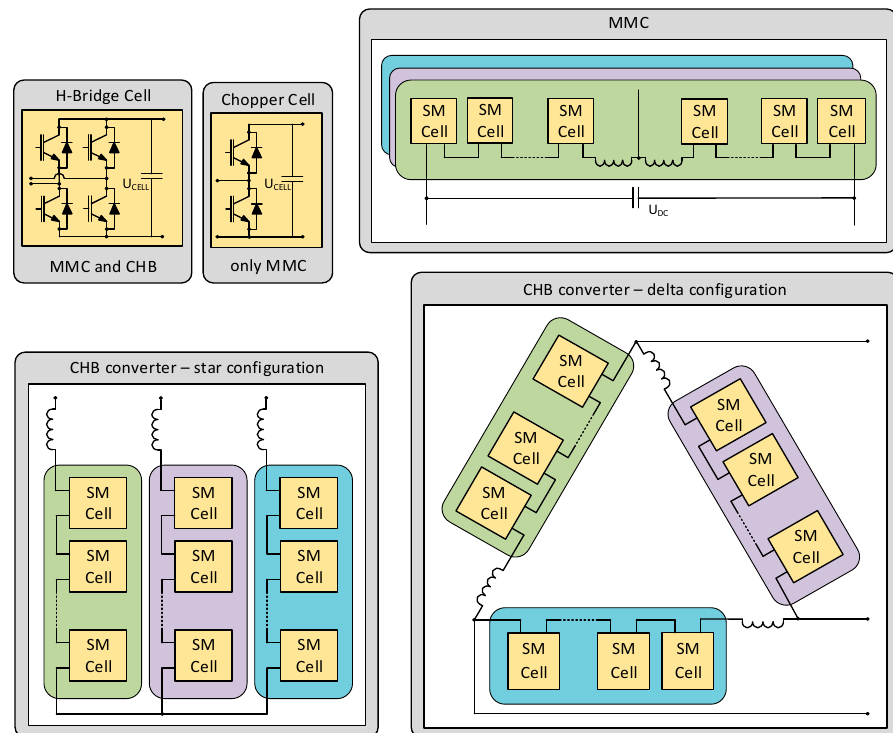
Figure 2. Modular multilevel converter and cascaded H-bridge converter topologies. The main topological difference is that MMC does have a common MV-DC link, while CHB does not. The lack of this link is also the main disadvantage of the CHB con- verter in SST application over the MMC, as it allows for MV-DC applications such as elec- tric vehicle (EV) charging stations. Thus, MMC outperforms its alternatives at high volt- ages utilization. Two CHB converter configurations are possible: star or delta. The star configuration is cheaper because of the lower number of SM cells for the same DC-link MV and semi- conductors voltage class values while providing almost the same efficiency at light and heavy loads as MMC [20]. The sizeable capacitive energy storage of the MMC also affects the cost of these units significantly. On the other hand, the delta configuration performs better at the distorted grid [11]. Unfortunately, for both CHB configurations under unbal- anced loads or grid disturbances, the issue of energy balancing arises both in-phase and interphase. If the DC voltages are not equal, the system may become unstable or even collapse. To solve the interphase balancing issue in the star configuration and to balance the energy between the converter’s arms, a zero-sequence voltage can be injected into each phase, while, in the delta configuration, the same function is performed by adding a zero- sequence current [11]. However, the same problem arises for the MMC—voltage unbal- ance between SM voltages can lead to the DC current injection into the grid [21]. Taking into account that the post-fault operation ability is one of the most important SST functionalities from the MV grid side point of view, despite slightly lower efficiency and the lack of a common MV-DC link, the star-connected CHB converter was chosen for further analysis. It has fewer SM cells than MMC and delta-connected CHB converters, which reduces the possibility of failure. Secondly, with a proper DC-MV to DC-LV con- verter topology, it can achieve a higher freedom degree of a post fault operation. Espe- cially a three-phase topology of a dual active bridge (DAB) converter with input parallel output parallel (IPOP) connection to the SMs—as shown in Figure 3—is most suitable [22,23]. If a failure in one SM cell occurs, or even if the whole DAB fails, the failed SM can